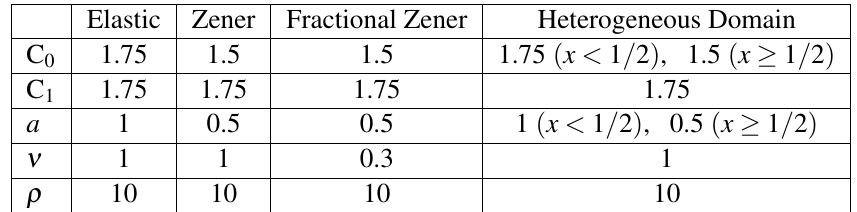
Table 4 The parameters used in in the fractional Zener model simulations to create the 2D spacetime plots shown in Figure 6